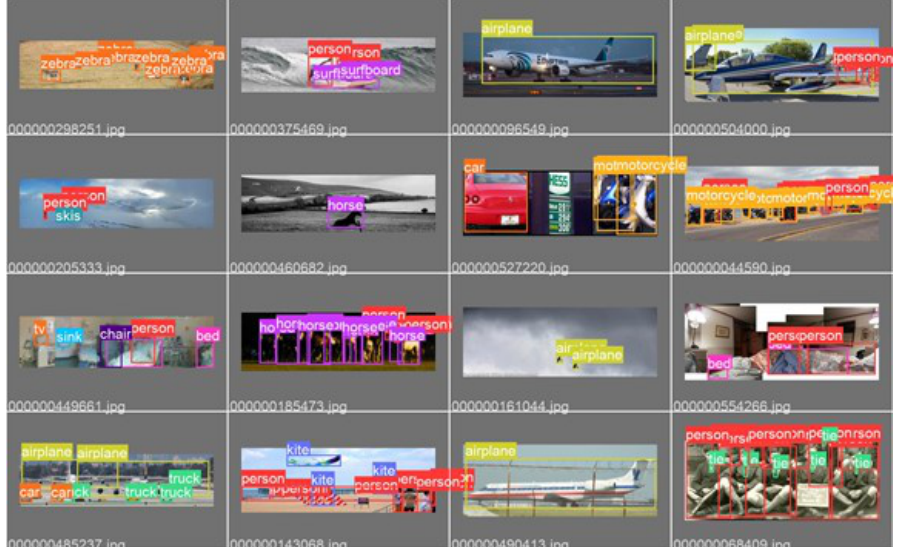
Figure 15. Examples of annotated images from the COCO test set—ground truth bounding boxes and classes visible.